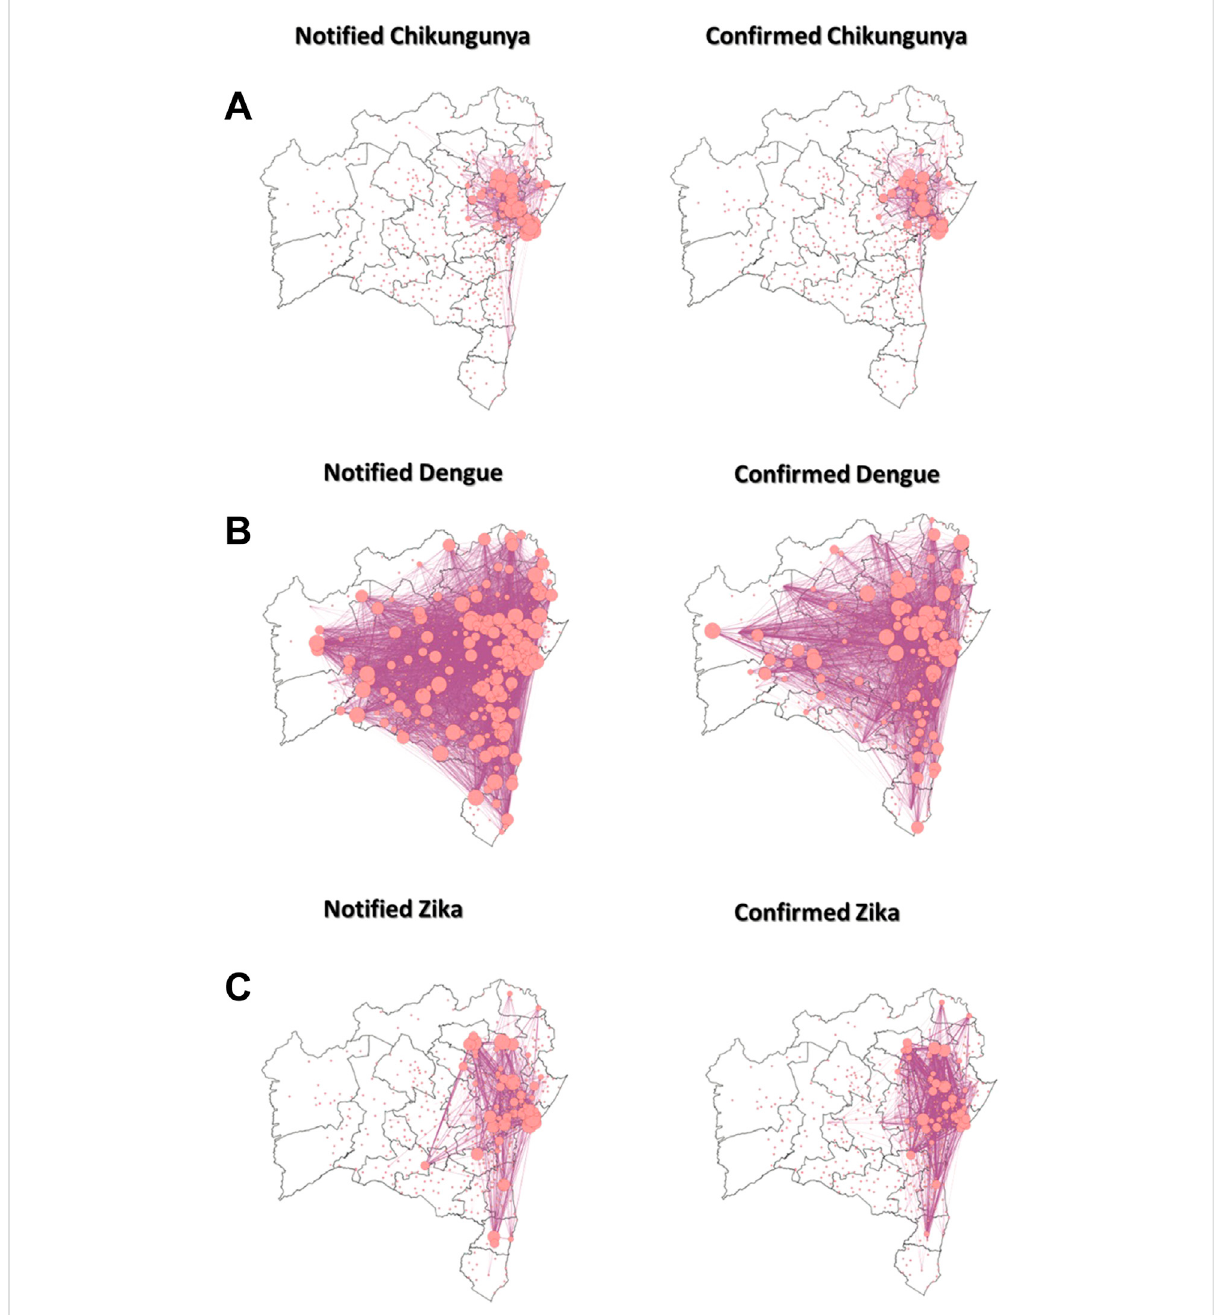
FIGURE 8 Noti fi ed and Con fi rmed Aggregate static networks (ASN ’ s) corresponding to the period of the Outbreak 1 for chikungunya (A) , dengue (B) , and Zika (C)